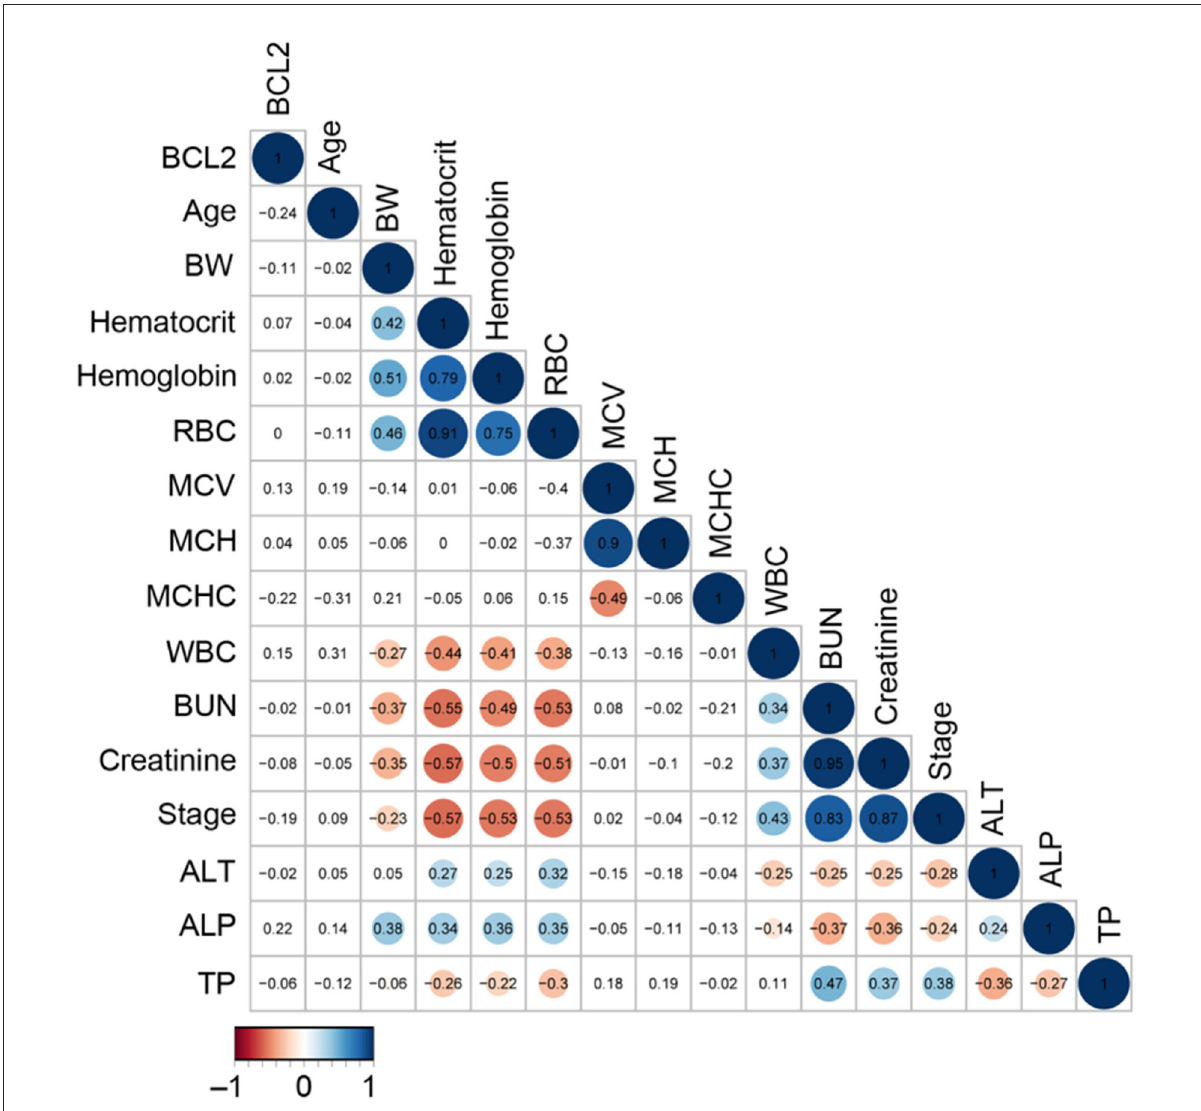
FIGURE5 The correlation analysis of circulating Bcl-2 with other blood parameters. The correlation matrix’s colored circles represent the correlation coefficients for each pair of Bcl-2 in the relevant cell-matrix.